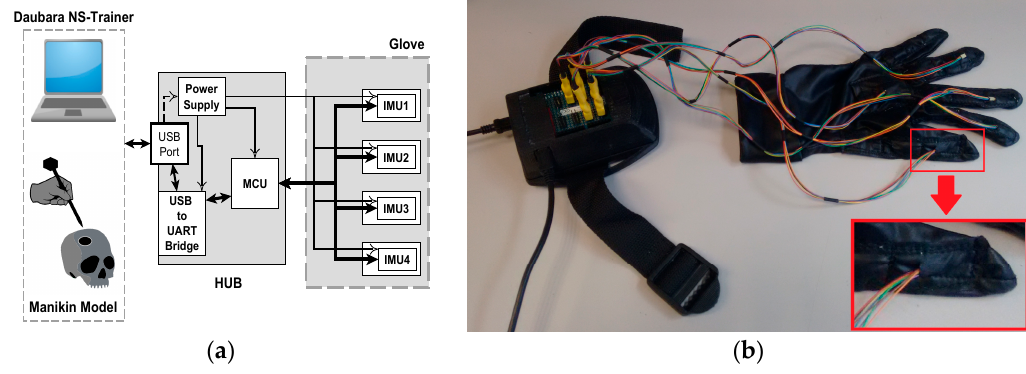
Figure 1. Hardware of IGlove system: ( a ) Block diagram of main parts of Hub and Glove and their interconnection. Microcontroller and sensors communicate in a single-master, multiple-slave configuration using SPI on a multidrop bus. IMU sensors were configured to sample internal signals from accelerometers and gyroscopes at 8 KHz, and the user-programmable digital low-pass filters were setting up to a cut-off frequency of 125 Hz, using the preconfigured low-pass filters of the sensor. Measurement data is sent via a high-speed USB link to the Daubara NS Trainer; sensors are sampled 100 times per second; ( b ) Picture of the system showing the connection between Glove and Hub. In this case, sensors were worn on thumb, index, middle, ring fingers, and in the back of the hand. A communication system that transfers data and power between Hub and each sensor has been implemented using a set of thin and flexible cables. A zoom of the thumb is presented in the lower right corner; it can be observed how power and data cables enter to one sensor compartment.